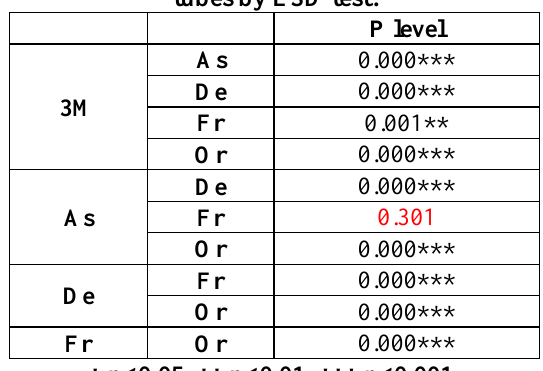
Table 7: Statistical difference between each two brands for the torsional play of the molar tubes by LSD